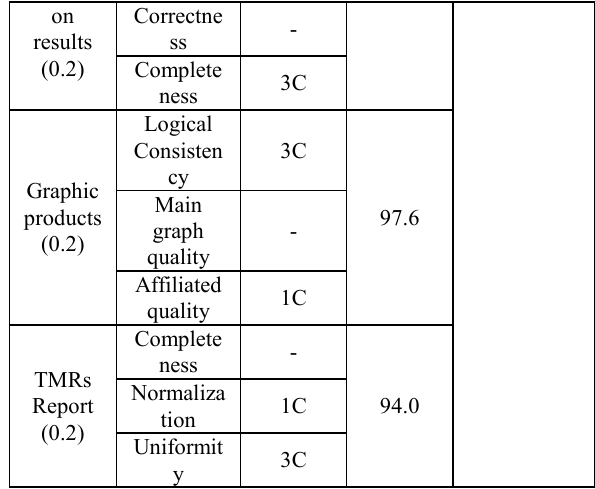
Table 5 .Quality Evaluation Table of Urban Geographic Situation Monitoring